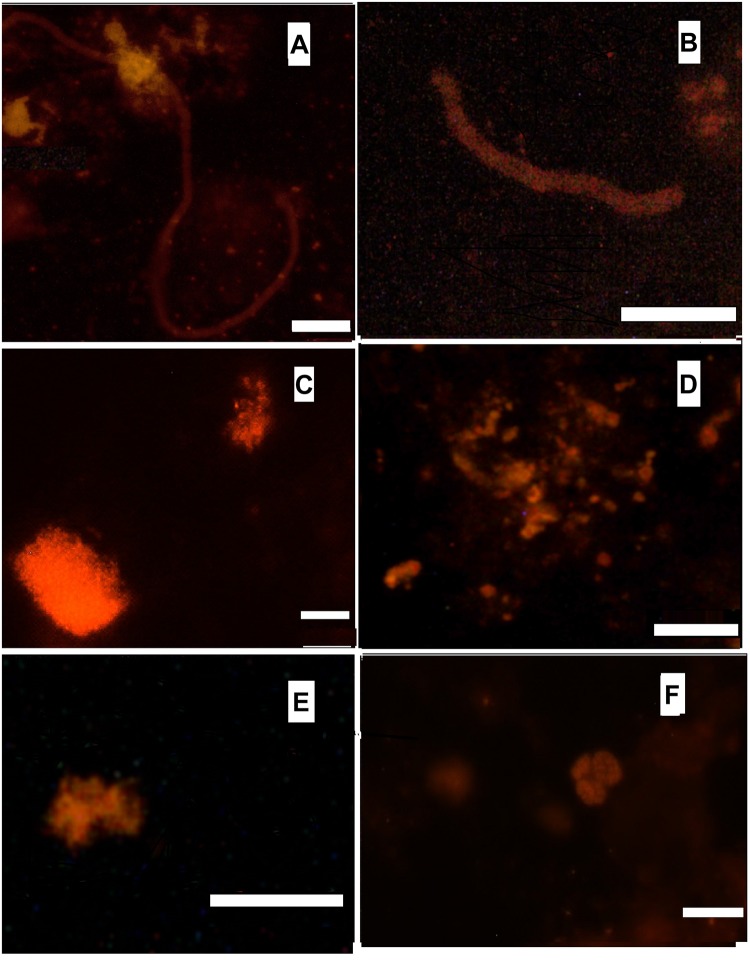
Hybridization with Cy-3 labeled probes. (A) CFX1223 (Phylum Chloroflexi), bar 10 μm; (B) CFX1223 (Phylum Chloroflexi), bar 5 μm; (C) NSE1472 (Nitrosomonas sp.), bar 5 μm; (D) EURY499 (methanogenic archaea), bar 10 μm; (E) Ntspn693 (Nitrospina gracilis), bar 5 μm; (F) Ntspa662 (Nitrospira sp.), bar 10 μm.